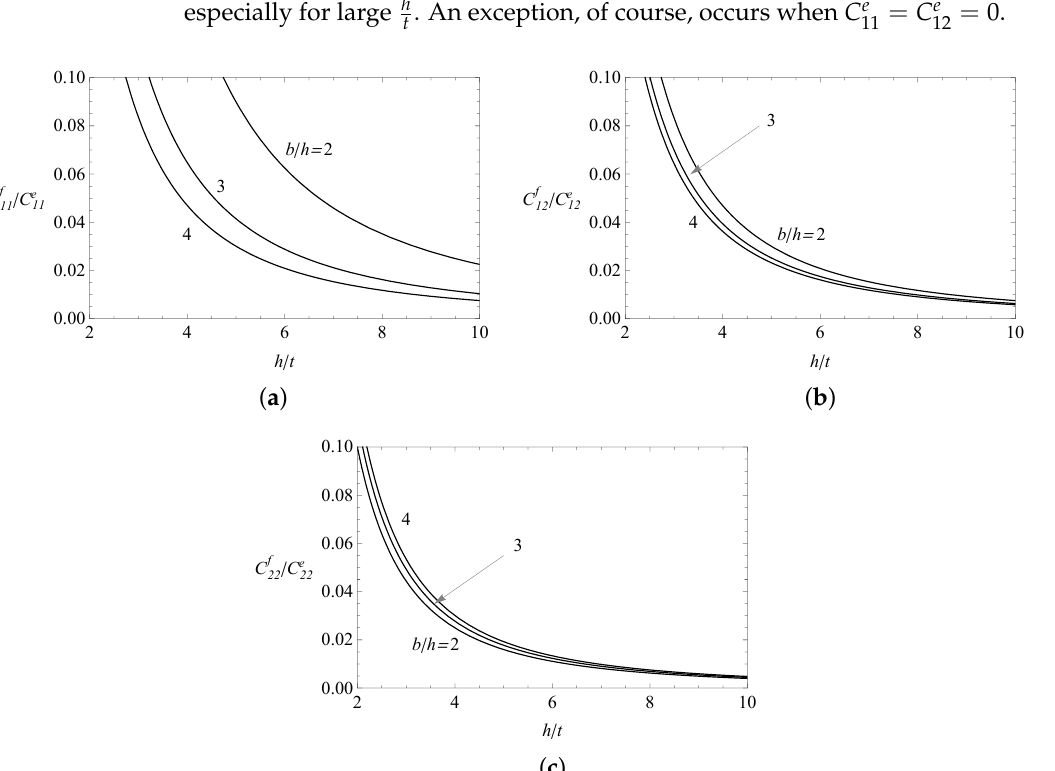
Figure 9. Flexural-to-extensional coefficient ratios vs. the height-to-thickness ratio for different b f f = ( b ) C , ( c ) C vs. h ; t 2 12 22 t t 1 C e 12 C e 22